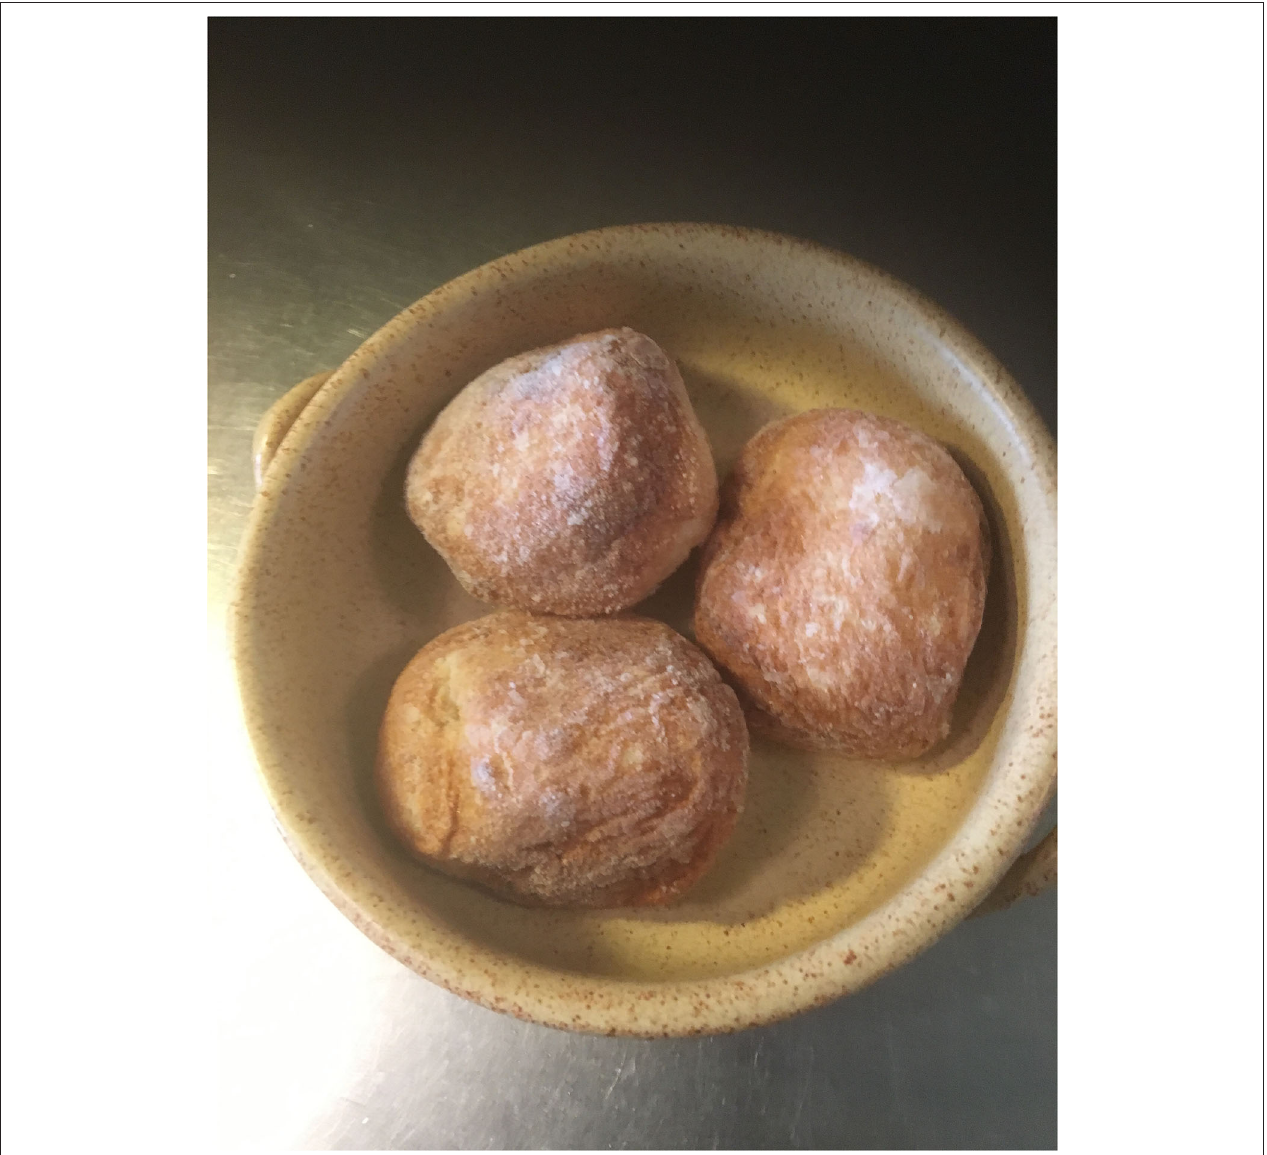
FIGURE 5 | Homemade fiskafrikadellur “a kind of fishcakes” consisting of fileted fish (cod or haddock). It is ground, then mixed with flour, spices and tallow, and finally fried (Photo Ingvar Svanberg 2019).